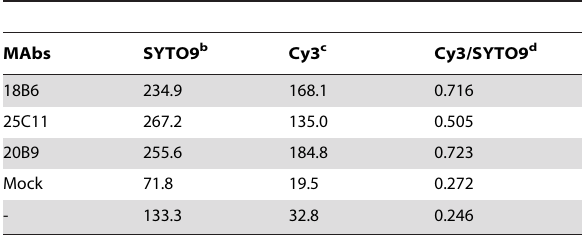
Table 2. Fluorescence quantities of the immuno-probed planktonic cells.